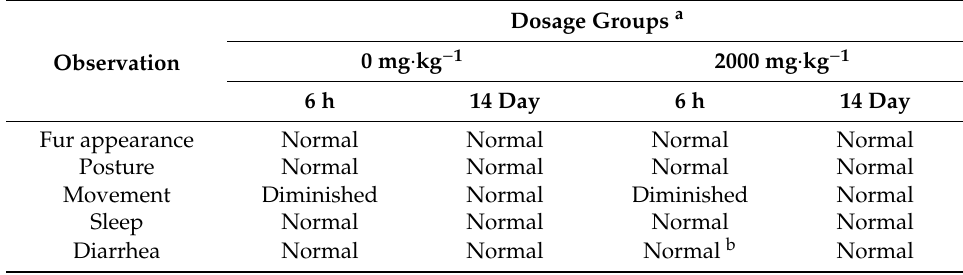
Table 3. Clinical observation of rats after acute oral administration (2000 mg · kg − 1 ) of a